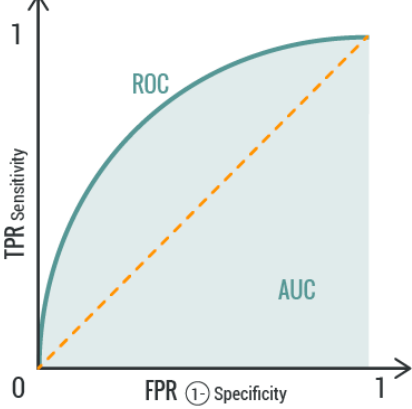
Figure 4. Receiver operating characteristic (ROC) curve.